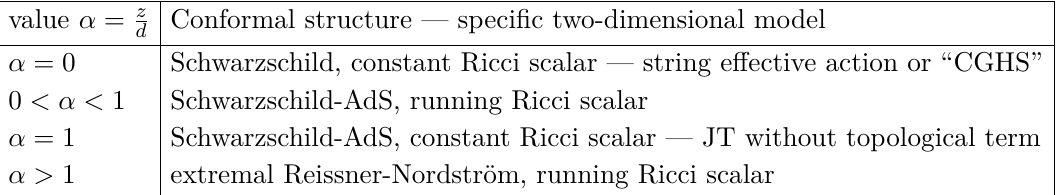
Table 1 . Classification of solutions of model presented in (1.1) with the electric field turned off. These were first studied in [16]. When turning on the electric field we get a conformal diagram similar to higher dimensional Reissner-Nordström with appropriate